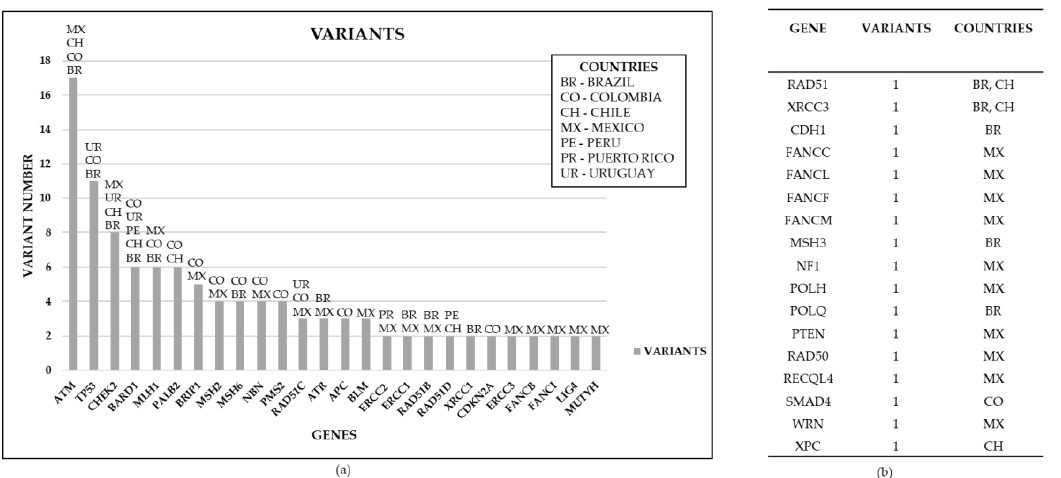
Figure 3. Non-BRCA gene variants reported from breast cancer patients in 7 LA countries. (a) Reported number of germline genes variants in breast cancer by country in LA; (b) Unique gene variants reported in LA countries.